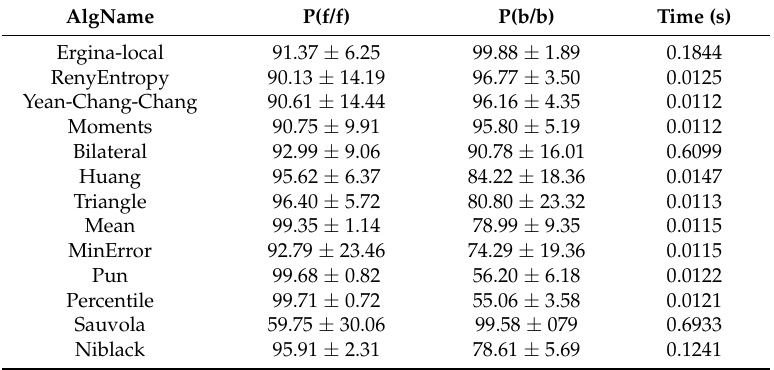
Table 3. Binarization results for images from Document Image Binarization Competition (DIBCO).